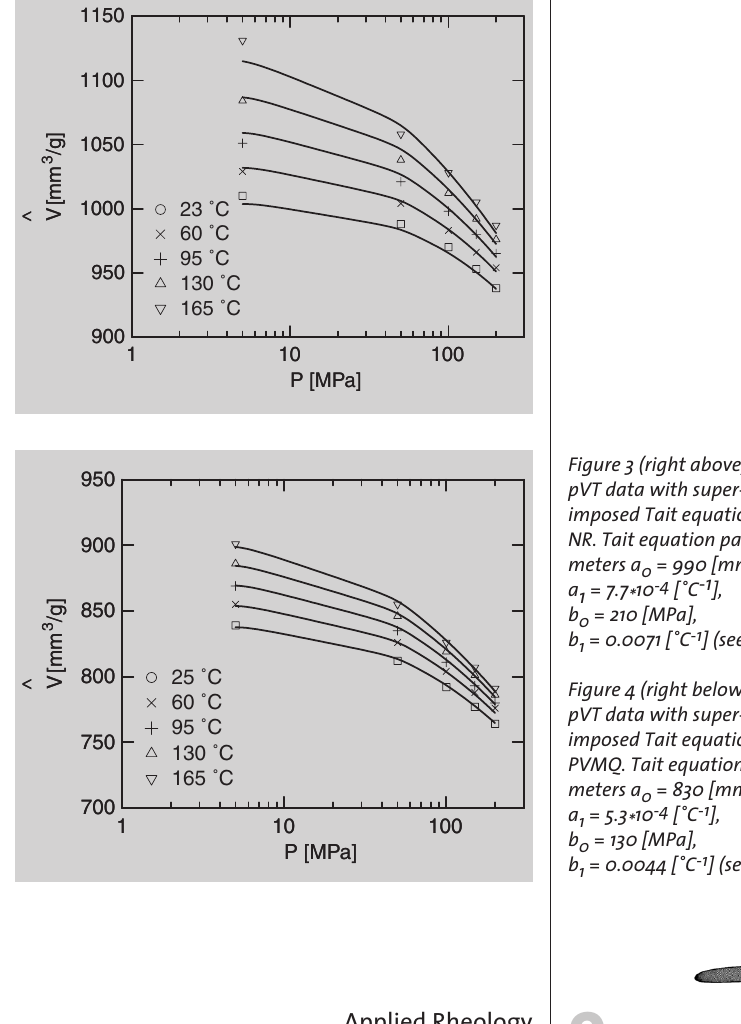
Figure 3 (right above): pVT data with super- imposed Tait equation for NR. Tait equation para- meters a 0 = 990 [mm 3 /g], a1 = 7.7*10 -4 [˚C-1], b 0 = 210 [MPa], b 1 = 0.0071 [˚C -1 ] (see Eq. 5). Figure 4 (right below): pVT data with super- imposed Tait equation for PVMQ. Tait equation para- meters a 0 = 830 [mm 3 /g], a 1 = 5.3*10 -4 [˚C -1 ], b 0 = 130 [MPa], b 1 = 0.0044 [˚C -1 ] (see Eq.